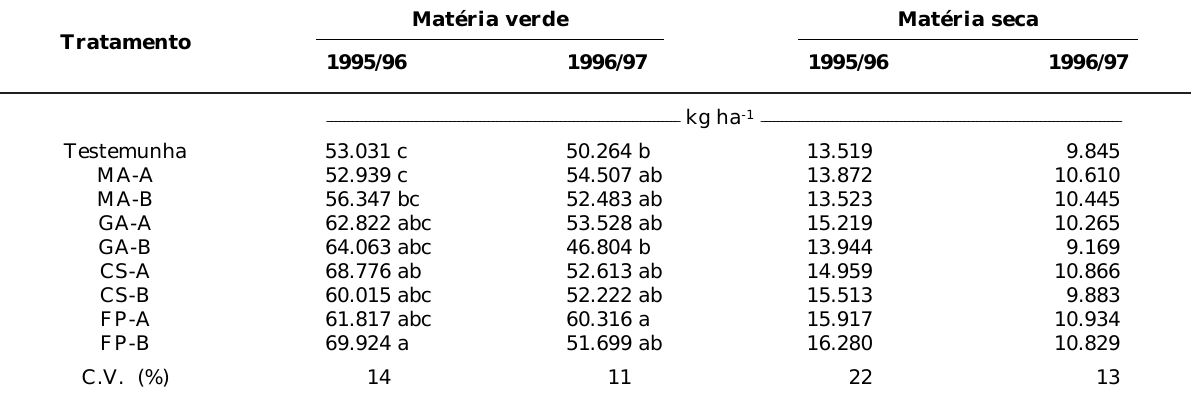
Quadro 3. Produção de matéria seca e verde das plantas de milho (anos agrícolas 1995/96 e 1996/97)